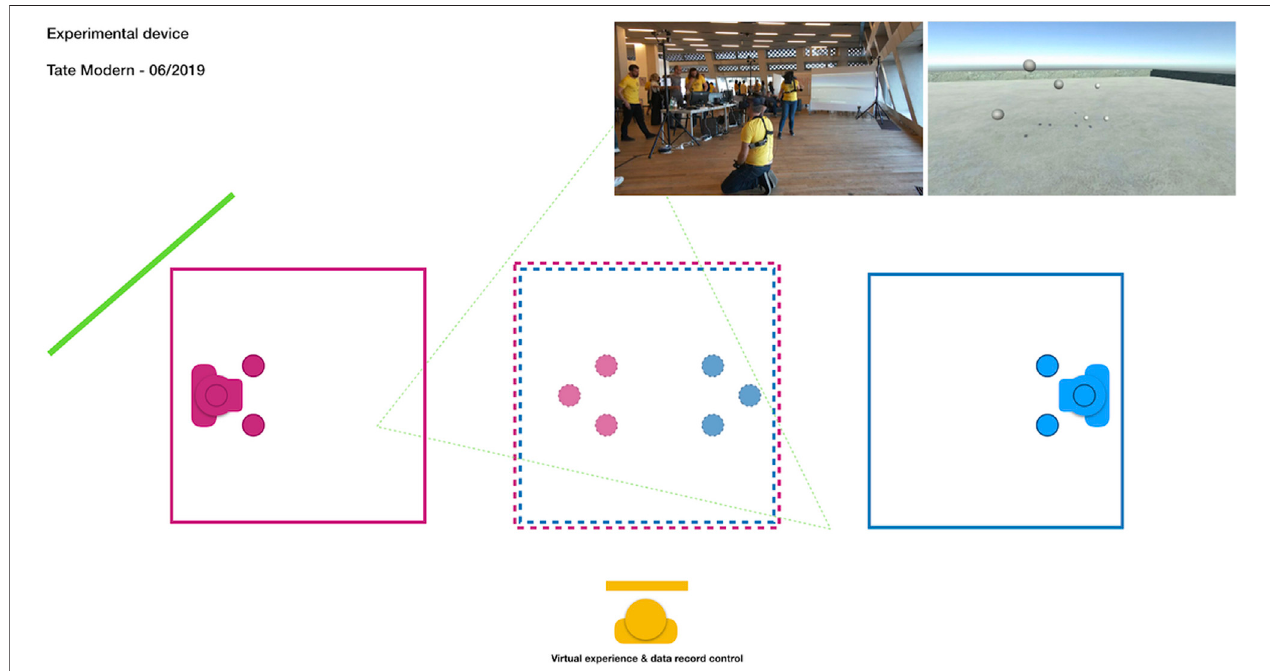
FIGURE10| Spatialcon fi gurationusedduringtheworkshopattheTateModerninJune2019.Thegreentrianglerepresentstheviewpointofthecameraprojecting a 2D representation of the experience on a screen (the green bar).